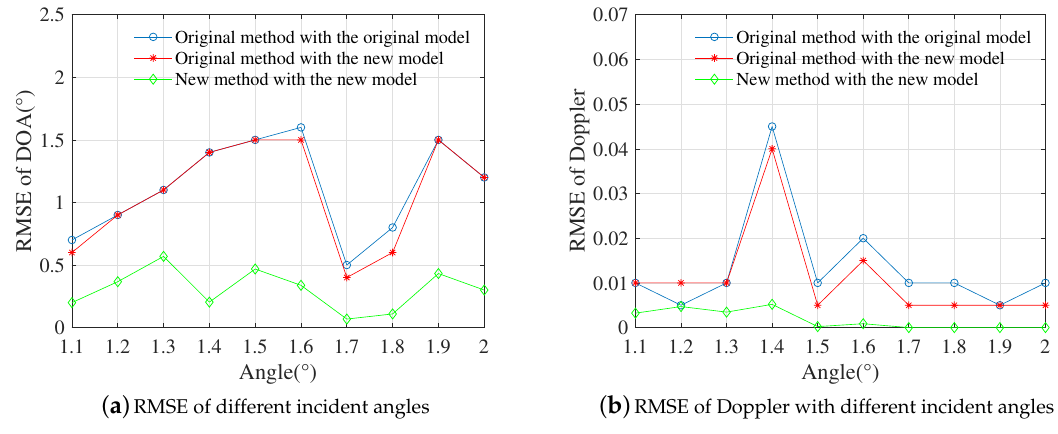
Figure 5. RMSE of three cases at SNR = 5